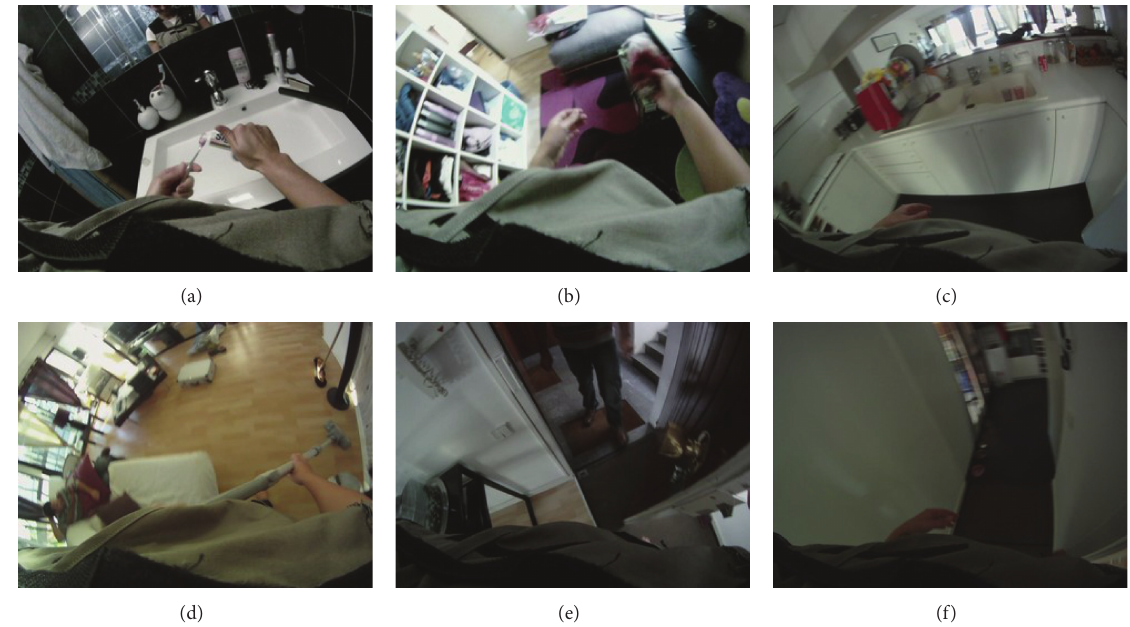
Figure 14: IMMED sample images: (a) bathroom, (b) bedroom, (c) kitchen, (d) living room, (e) outside, and (f) other.